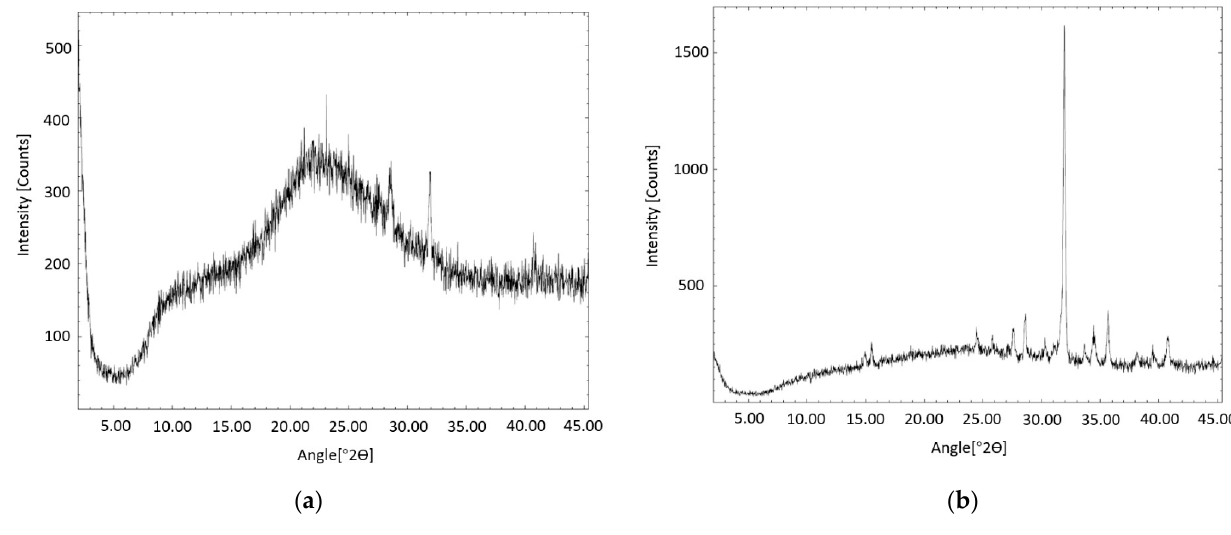
Figure 5. XRD plots of ( a ) AC/Lig-MnO 2 and ( b ) Lig-MnO 2.